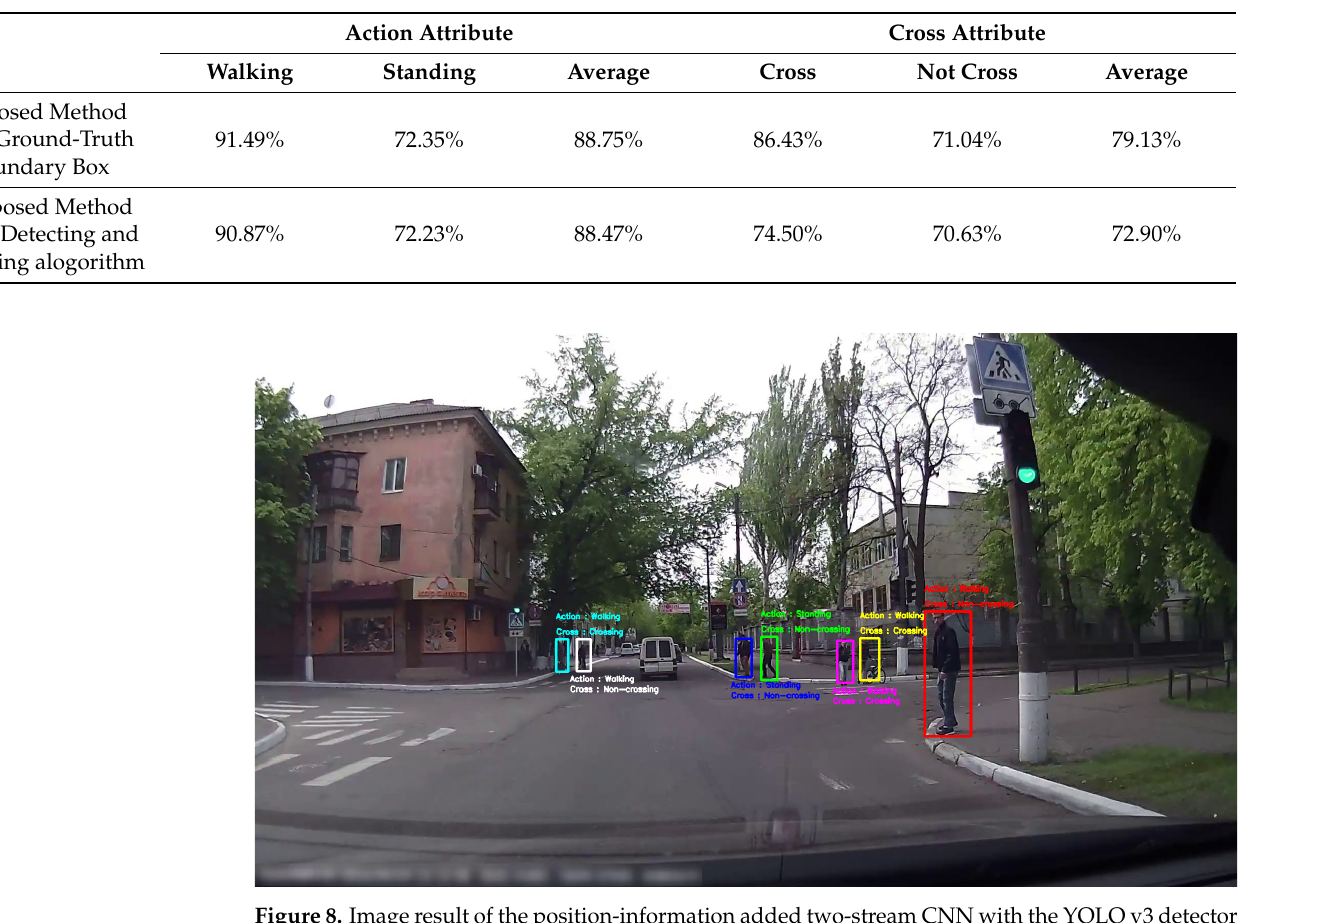
Table 8. Comparison of the model with and without the ground-truth boundary box.